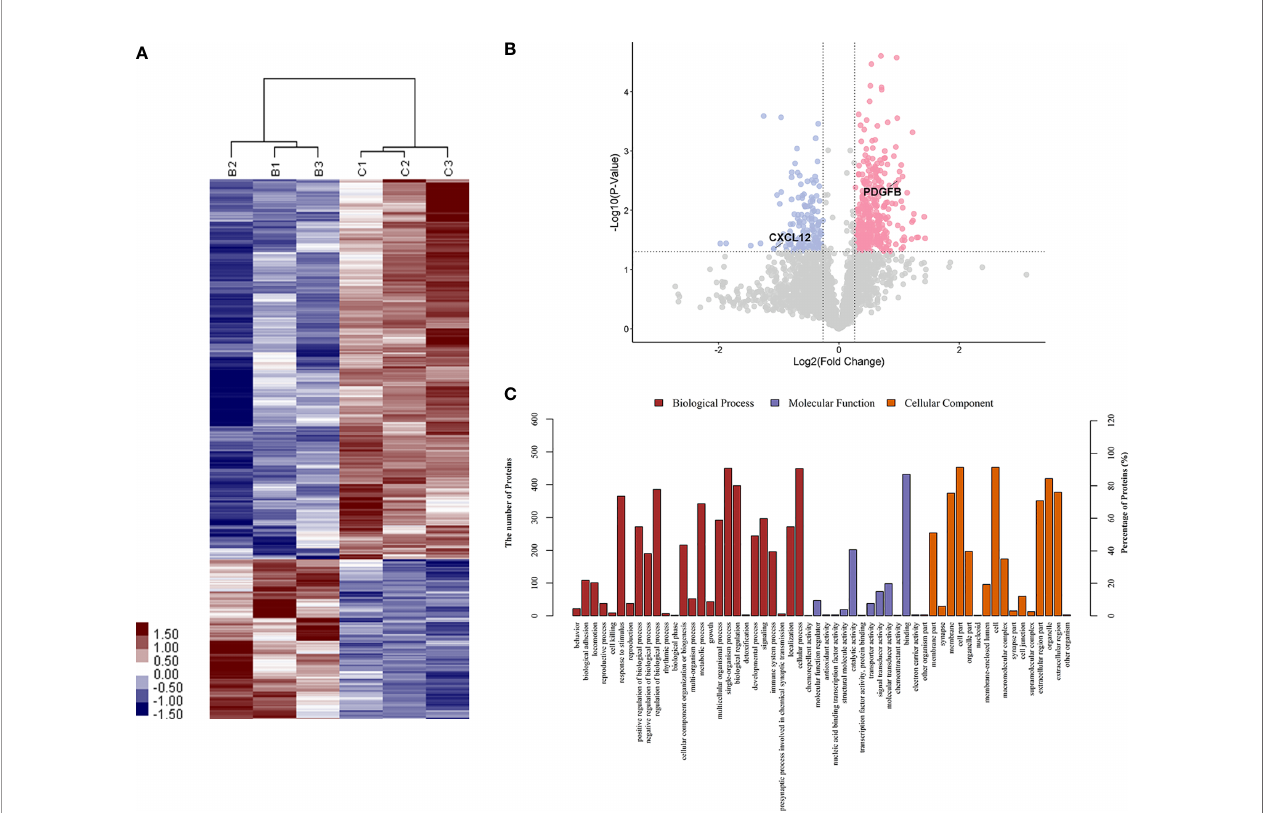
FIGURE 3 | The differentiated urine proteins between patients with OAPS and patients with TAPS analyzed by iTRAQ study. (A) Cluster analysis of OAPS with TAPS (B represented TAPS; C represented OAPS). (B) Volcano plot showed that PDGFB was in the upper right quadrant, which was in pink color area. CXCL12 was in the upper left quadrant, which was in blue color area. (C) Gene ontology (GO) analysis of OAPS vs TAPS. iTRAQ, isobaric tags for relative and absolute quanti fi cation; OAPS, obstetric antiphospholipid syndrome; HCs, healthy